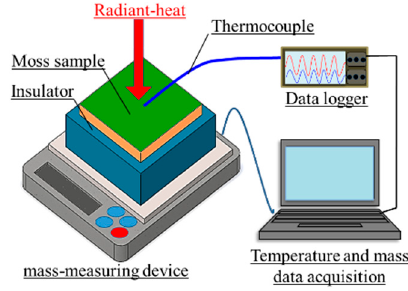
Figure 6. A schematic of the measurement setup in a laboratory experiment.